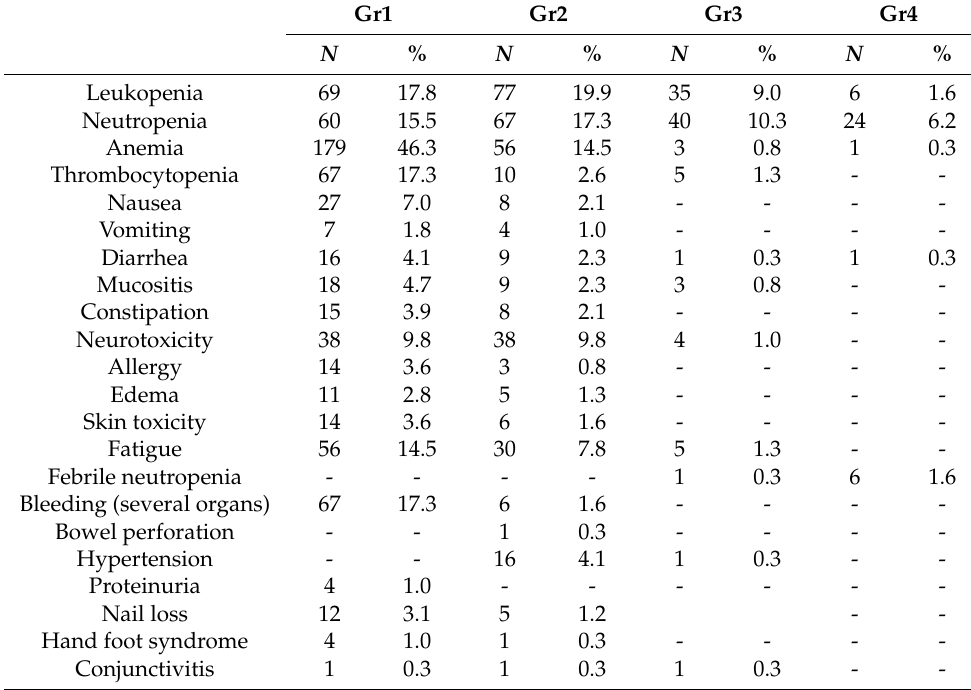
Table 2. Adverse events related to BEV in combination with